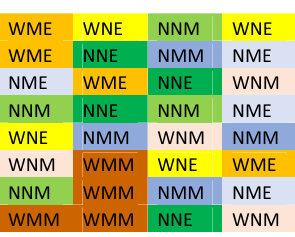
Figure 1: Schematic diagram of the pot set up of the experiment. Treatment codes are built up as follows: fi rst letter for earthworm ( W ) or no worm ( N ) added; for the second letter for manure ( M ) or no manure ( N ) added; the third letter for Earth control soil ( E ) and Mars soil simulant ( M )